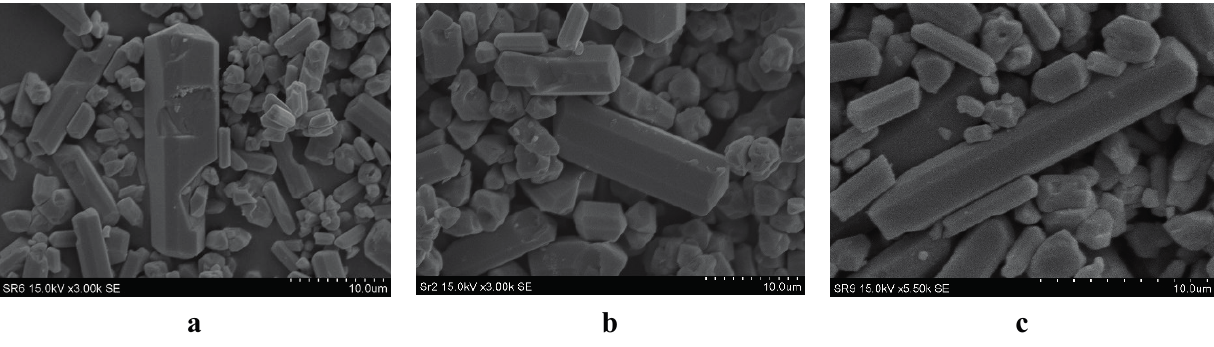
Figure 4. SEM image of Ln(form) 3 MOF compounds with Nd/Eu of 0.49 ( a , average crystals size ≈ 3 μ m), 1.59 ( b , av. crystal size ≈ 5 μ m), and 5.14 ( c , av. crystals size ≈ 6 μ